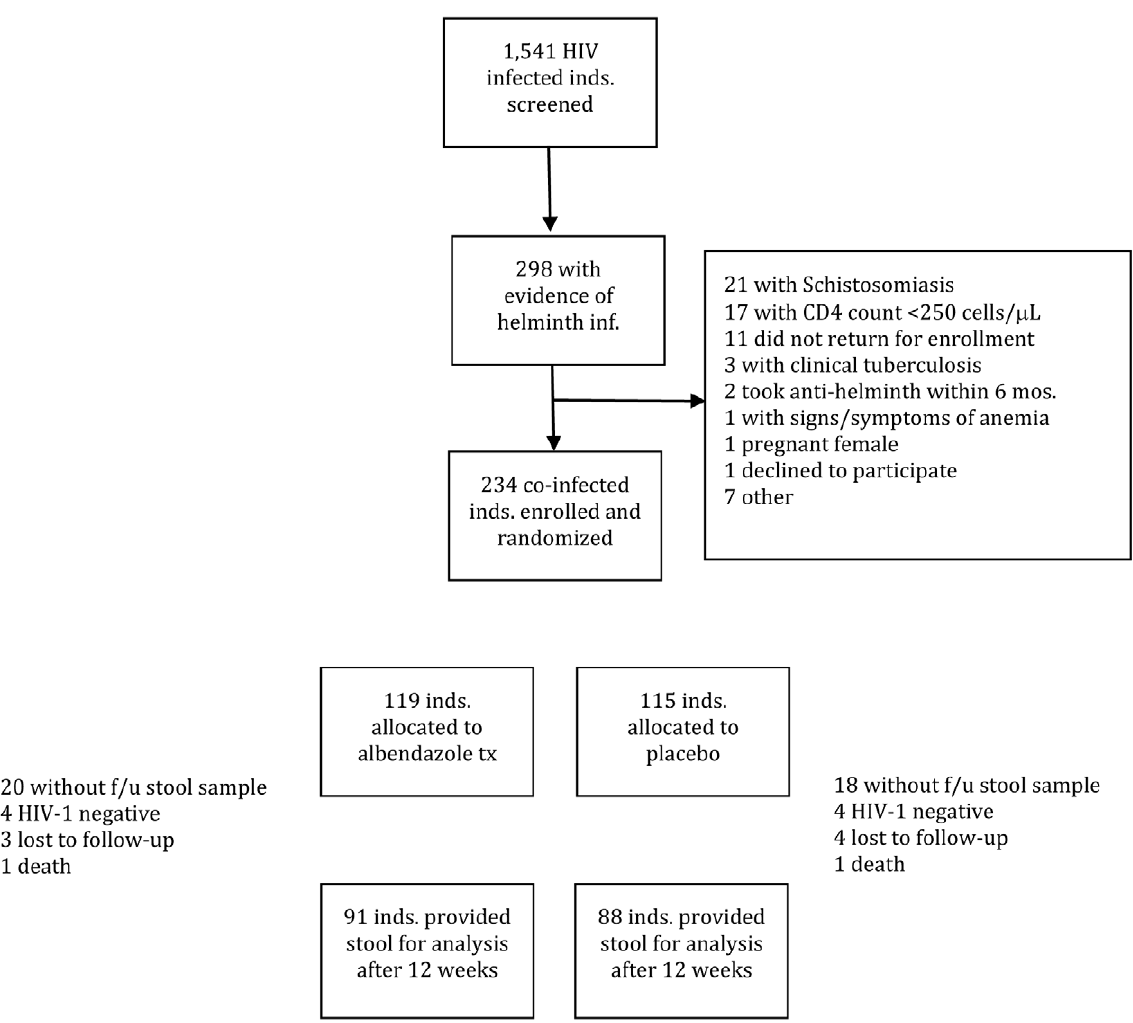
Figure 1. CONSORT flowchart of study screening and enrollment.